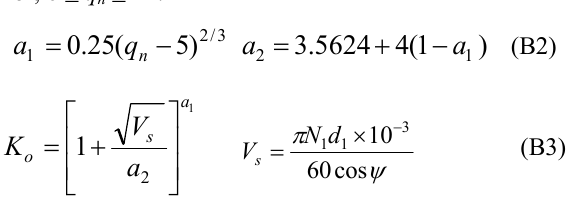
Material Factor ( α m )